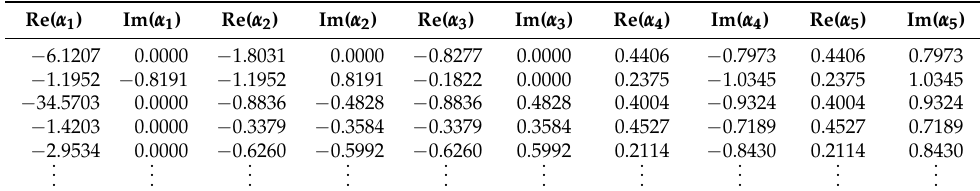
Table A2. Head of the output data set for training the ANN 5 for computing both real